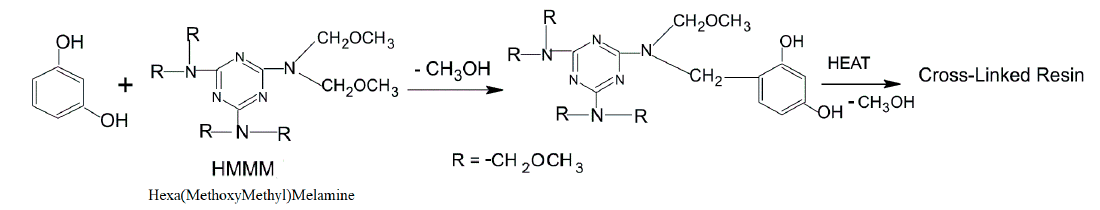
Figure 1. Scheme of the crosslinking reaction of the used phenolic resin.